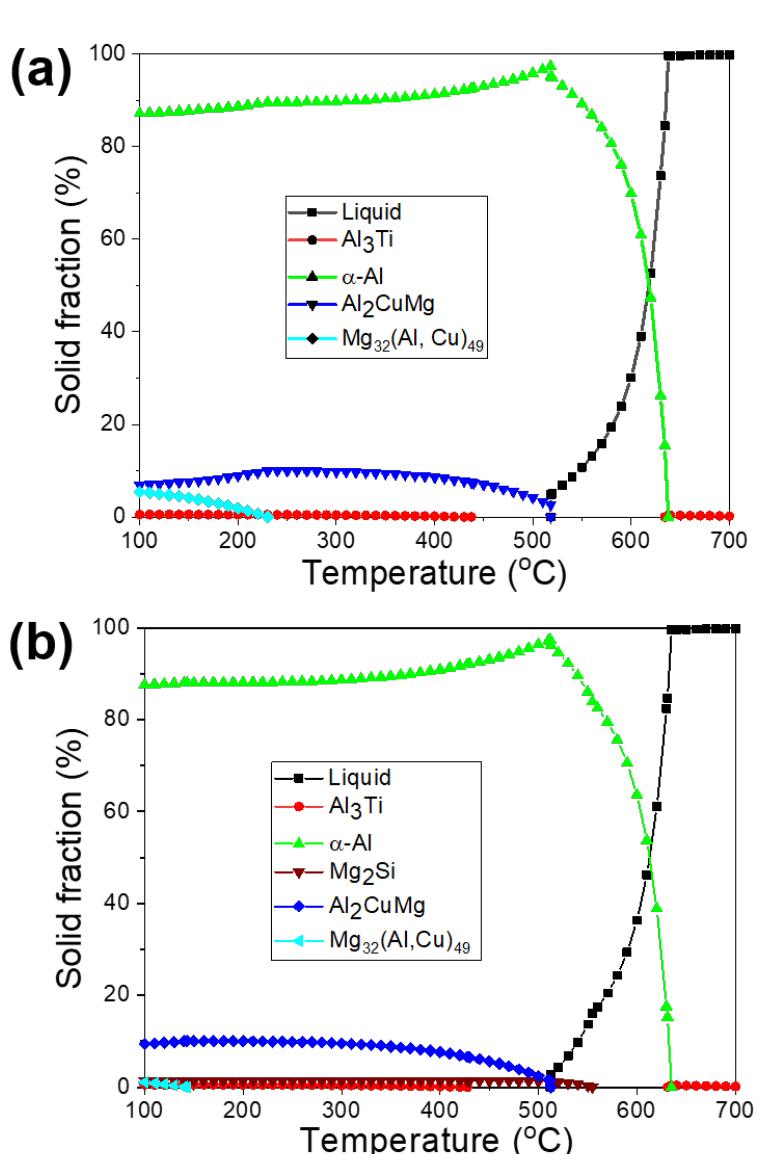
Figure 1. Results of theoretical calculations conducted using JMatPro 7.0 to evaluate different phases during the solidification process of the B43 and S43 alloys, as shown in ( a ) and ( b ), respectively.